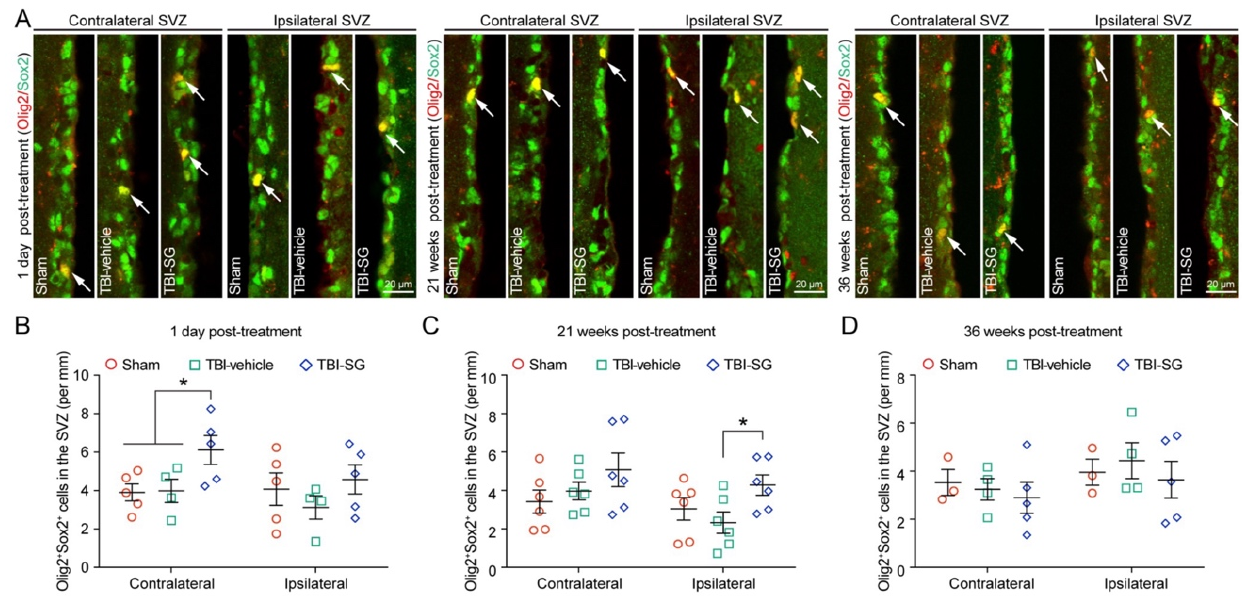
Figure 5. SCF+G-CSF treatment increases the number of oligodendrocyte progenitor cells (OPCs) in the subventricular zone (SVZ) in the chronic phase of severe TBI. ( A ) Representative images of Olig2 + Sox2 + double-positive OPCs (the arrow-indicated yellow cells) in the contralateral and ipsilateral SVZ at 1 day, 21 weeks, and 36 weeks post-treatment. ( B – D ) Quantitative data of analysis of the number of OPCs in the SVZ at 1 day ( B ), 21 weeks ( C ), and 36 weeks ( D ) post-treatment in three experimental groups. Two-way ANOVA followed by Fisher’s LSD test. * p < 0.05. Scale bars: 20 µm. SG: SCF+G-CSF.